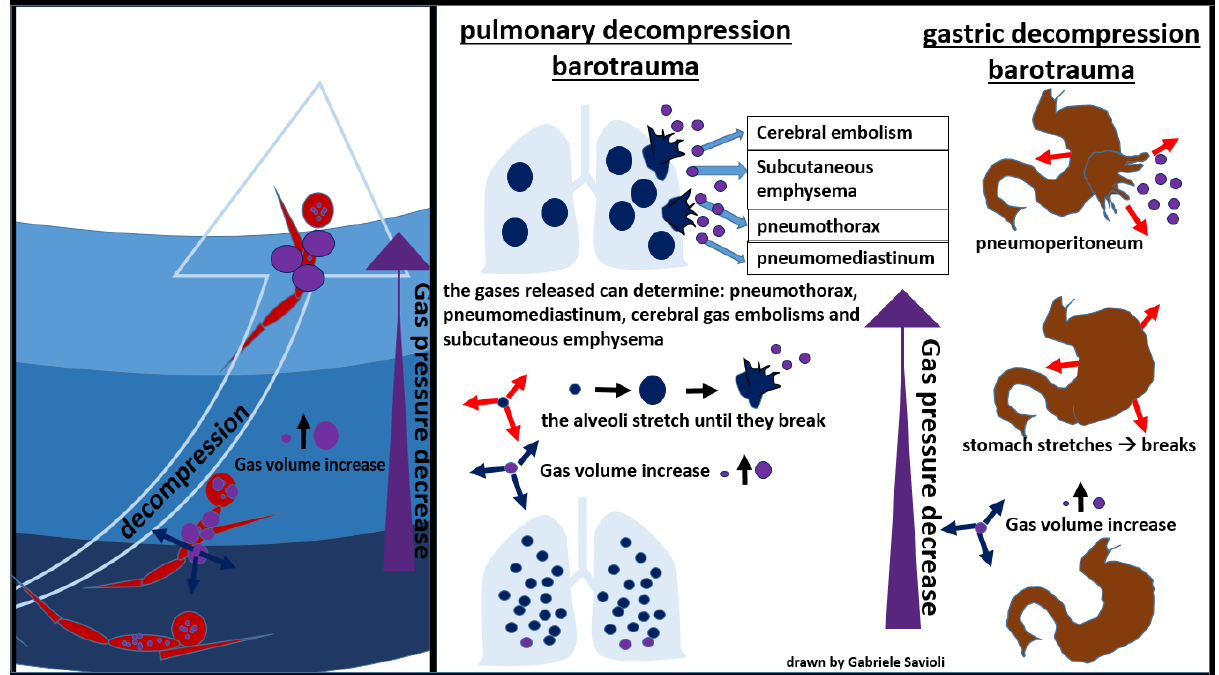
Figure 6. Decompression